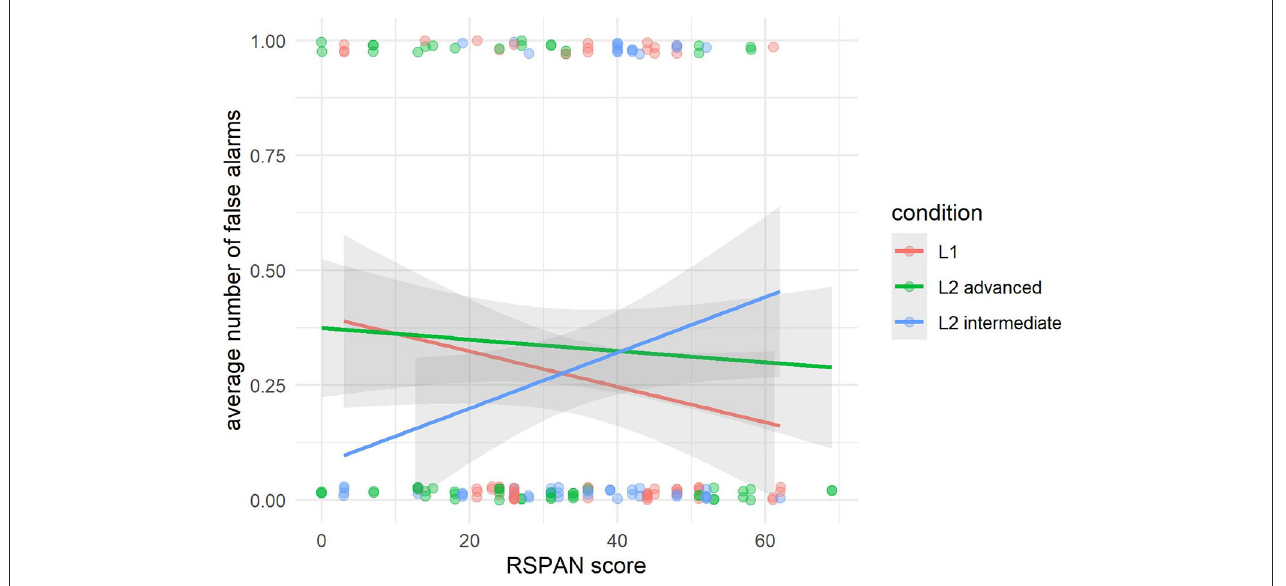
FIGURE 3 | Presence of false alarms as mediated by condition and